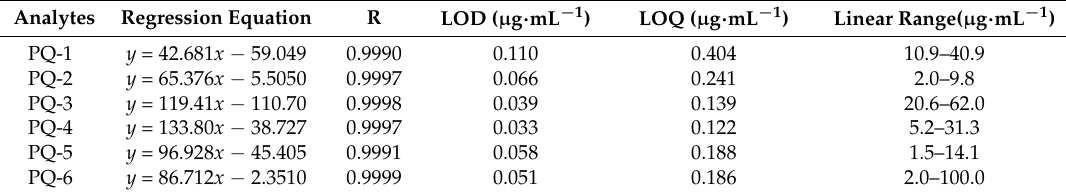
Table 2. Typical calibration curves of the six analytes ( n = 6) 1